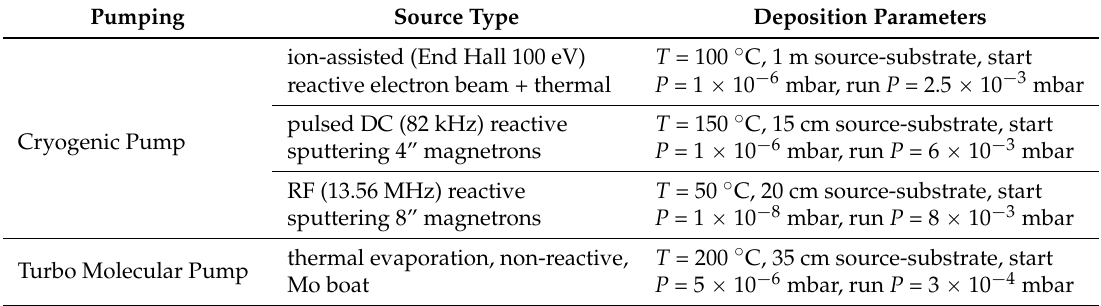
Table 1. Deposition techniques and associated parameters: T = substrate temperature; P = chamber pressure.